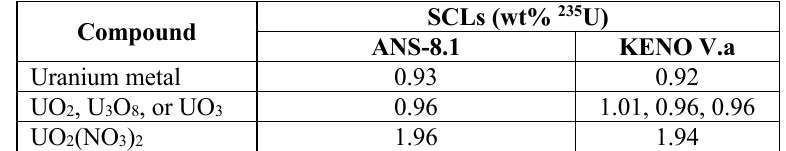
Table II. 235 U enrichment SCLs for uranium mixed homogenously with